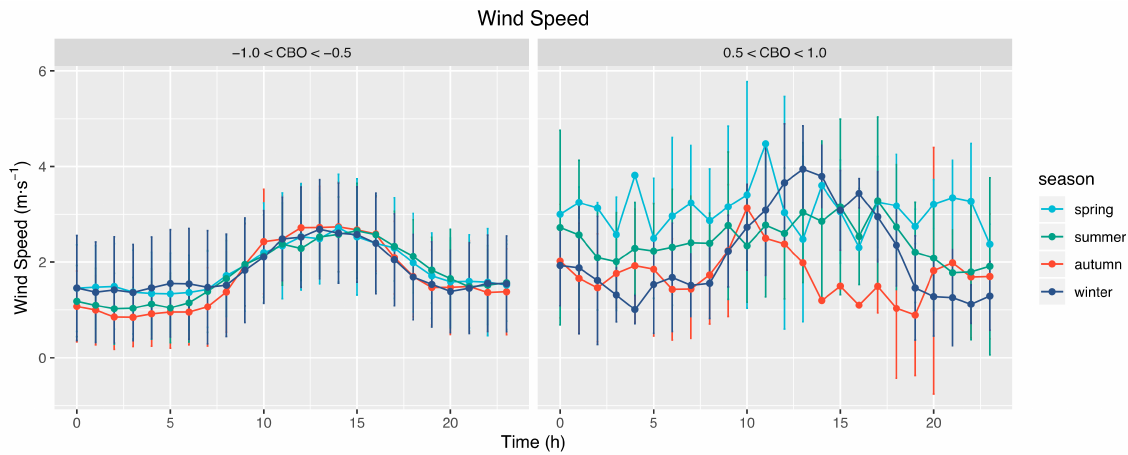
Figure 12. Diurnal variations of wind speed in two situations: ( left ): − 1.0 < CBO < − 0.5 and ( right ): 0.5 < CBO < 1.0.